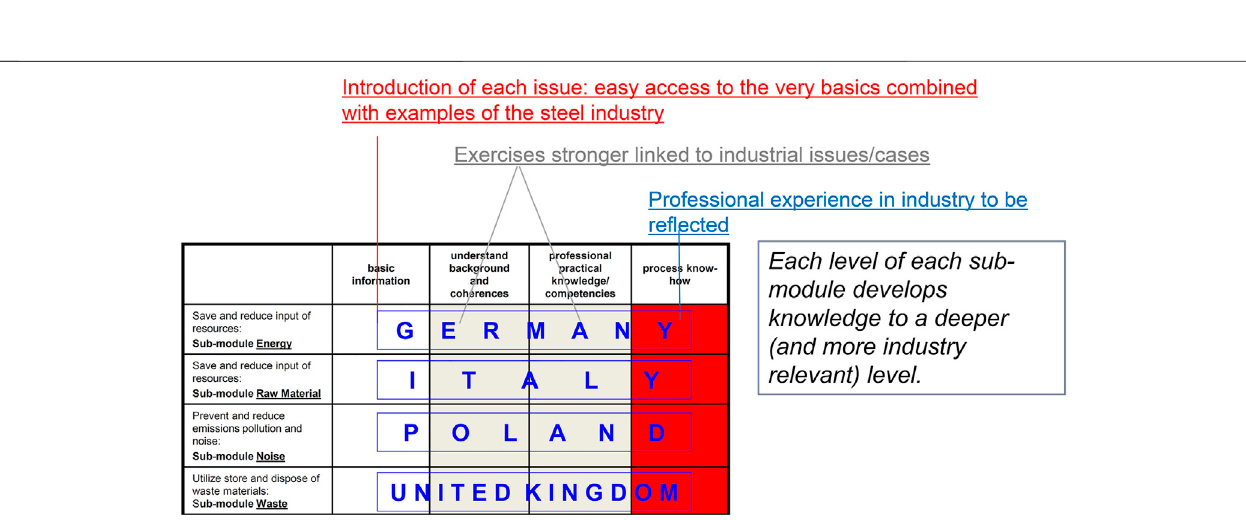
FIGURE 4 | GT-VET training module (Schröder et al., 2013, permission